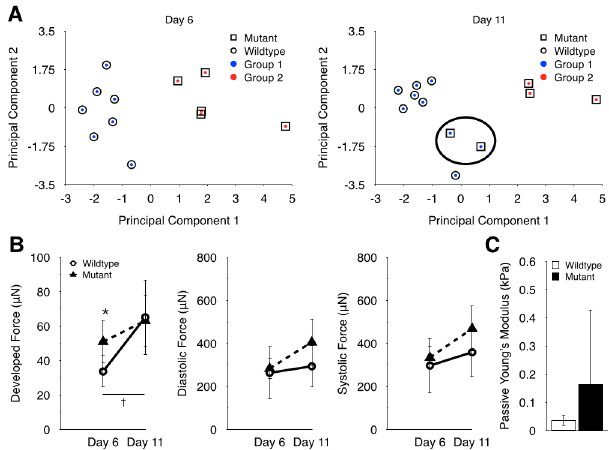
Fig 4. Investigating longitudinal changes in hECT functional phenotype. ( A ) Principal component analysis and k-means clustering of tissues paced at 2 Hz on day 6 (left) and day 11 (right). ( B ) Developed force of the wild-type tissues increased significantly over day 6 and day 11, while mutant tissues did not. The lack of a significant change from day 6 to day 11 appeared to be due to a greater increase in diastolic force of mutants from day 6 to 11 than wild-type tissues, while systolic force increased approximately by the same amount for both tissue types. ( C ) Passive Young ’ s modulus determined by uniaxial stretch measurements on days 12 – 15 (n = 4 per tissue type). * p < 0.05 between tissues types, † p < 0.05 between day 6 and day 11 for wild-type tissues.